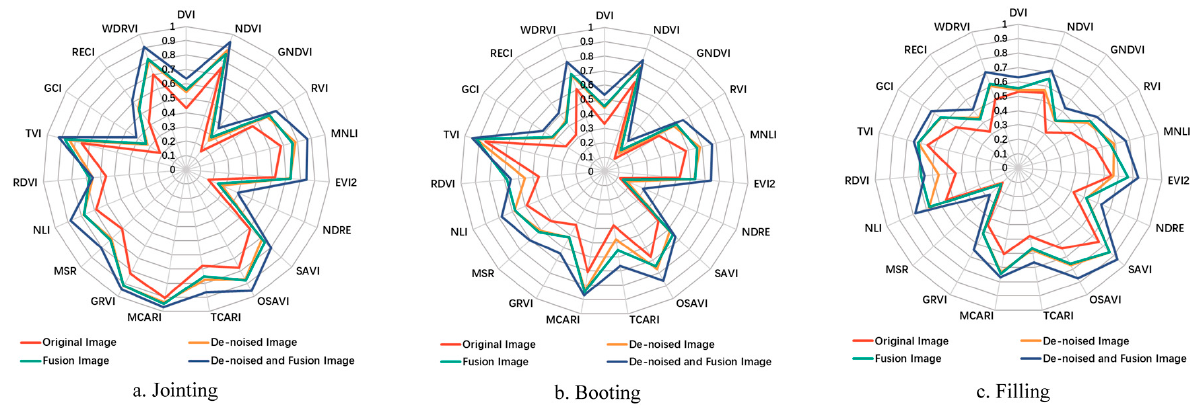
Figure 8. Correlation Coefficient between VIs with LNC based on processed images at different stages.